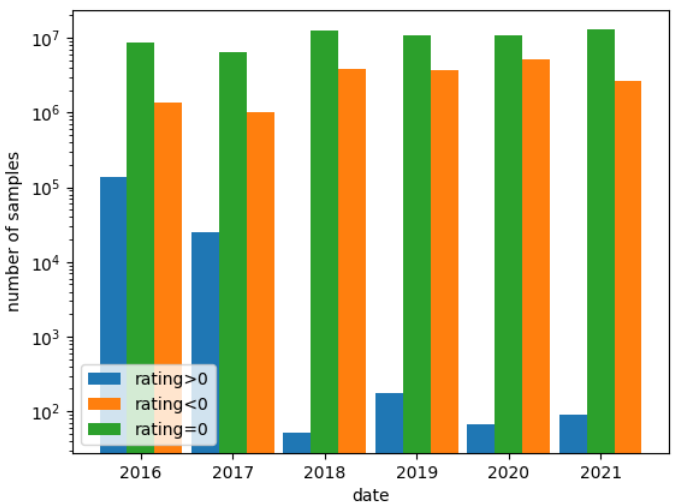
Figure 3. Data distribution in the Koodous platform from 2016 to 2021 (note a logarithmic